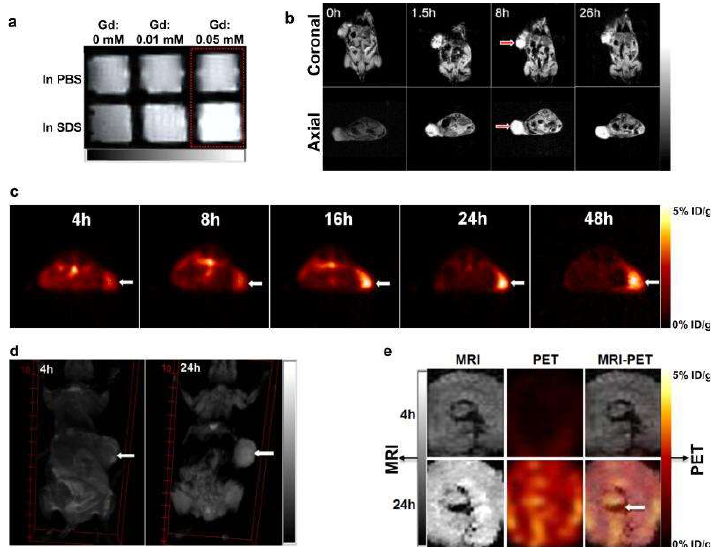
Figure 14. NPor-mediated MRI and PET imaging in animal models. ( a ) MRI signal of Gd-NPors in the presence and absence of SDS obtained in vitro by T 1 -weighted MRI; ( b ) representative coronal and axial MRI images of transgenic mice with mammary cancer (FVB/n Tg(MMTV-PyVmT)) at pre-injection and post-injection of 0.15 mL Gd-NPors (Gd dose = 0.015 mmol/kg); red arrows point to the tumor site; ( c ) PET image of nude mice bearing SKOV3 ovarian cancer xenografts at 4, 8, 16, 24, and 48 h post-injection of 64 Cu-NPors (150–200 μL, 64 Cu dose = 0.6–0.8 mCi); white arrows point to the tumor site; ( d ) 3D coronal MRI images of nude mice bearing A549 lung cancer xenografts at 4 or 24 h post-injection with 0.15 mL of 64 Cu and Gd dual-labeled NPors (150–200 μL, 64 Cu dose = 0.6–0.8 mCi, Gd dose = 0.015 mmol/kg); white arrows point to the tumor site; ( e ) PET-MRI images of tumor slices of nude mice bearing A549 lung cancer xenografts at 4 or 24 h post-injection of dual-labeled NPors; white arrows point to the necrotic area in the center of the tumor. Reproduced from Reference [50] with permission from Nature Communications , 2014.